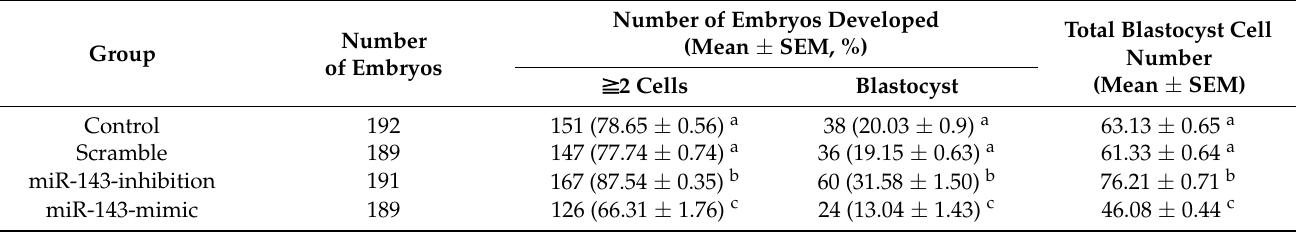
Table 3. Evaluation of development in embryos microinjected with miR-143.